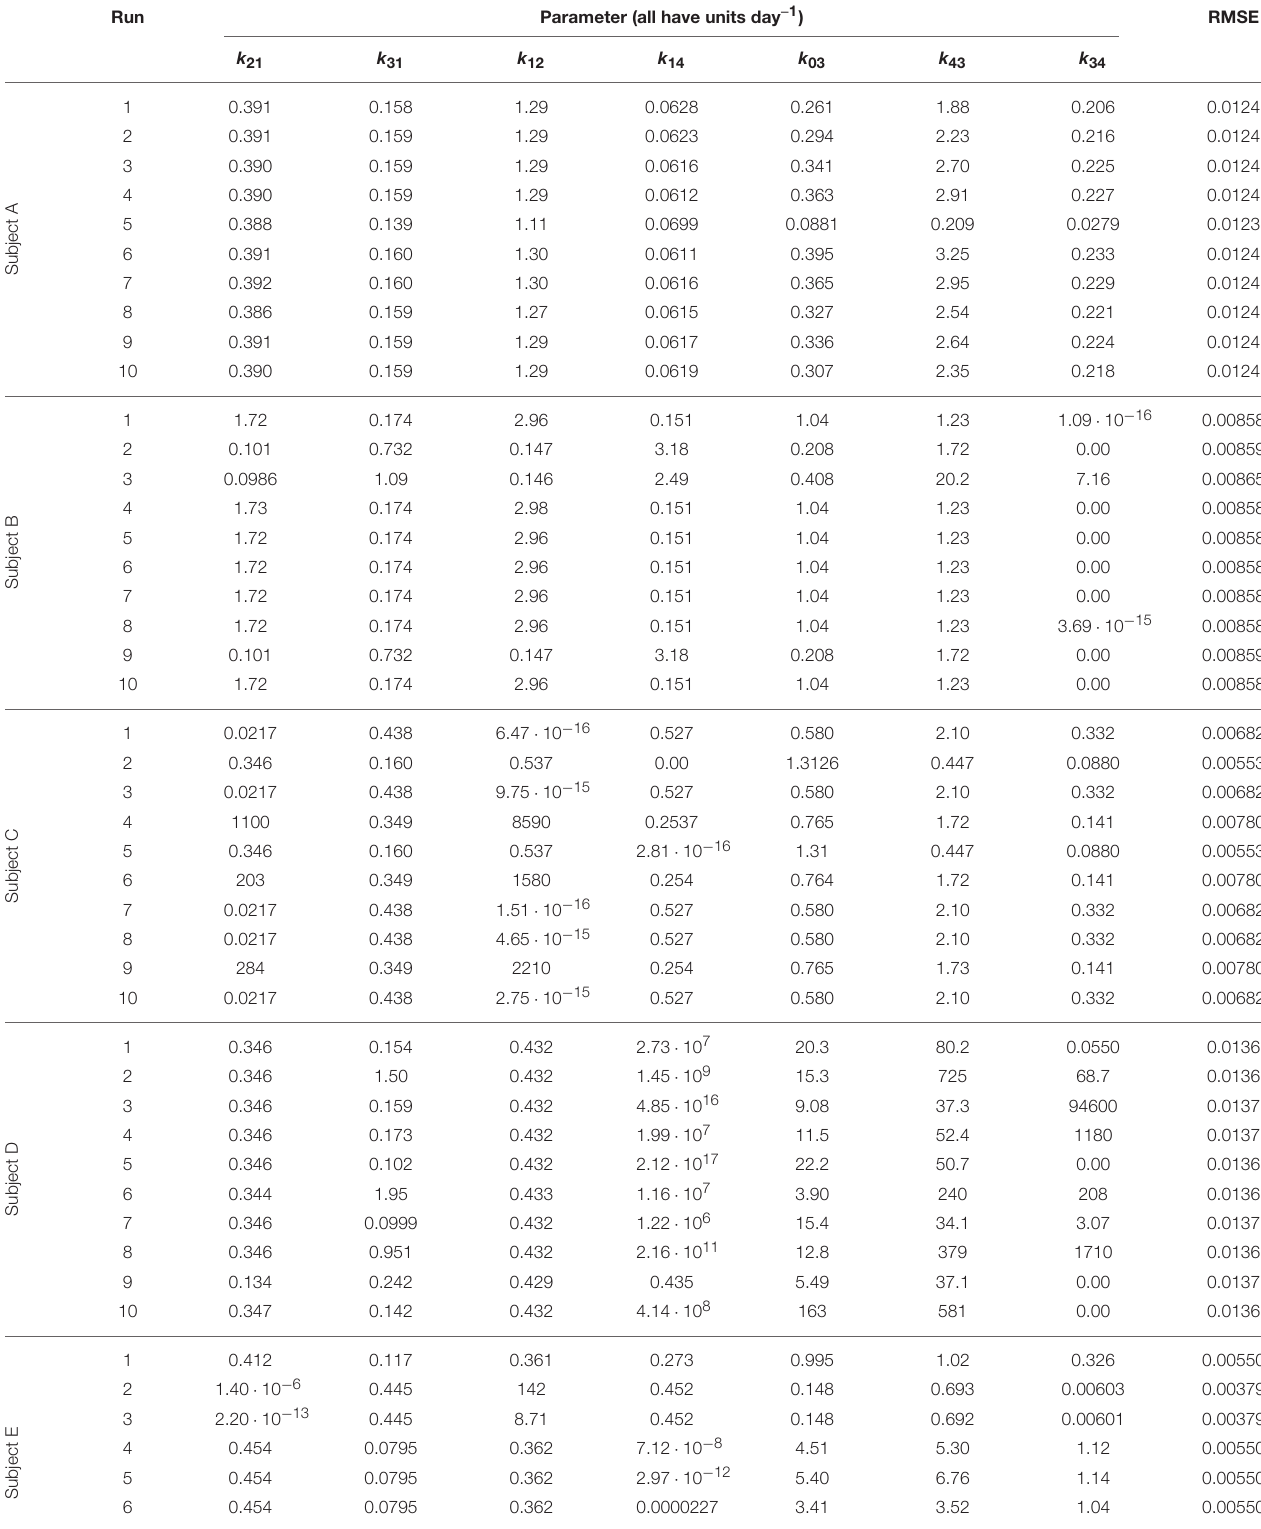
TABLE 3 | Parameter values estimated from timecourse